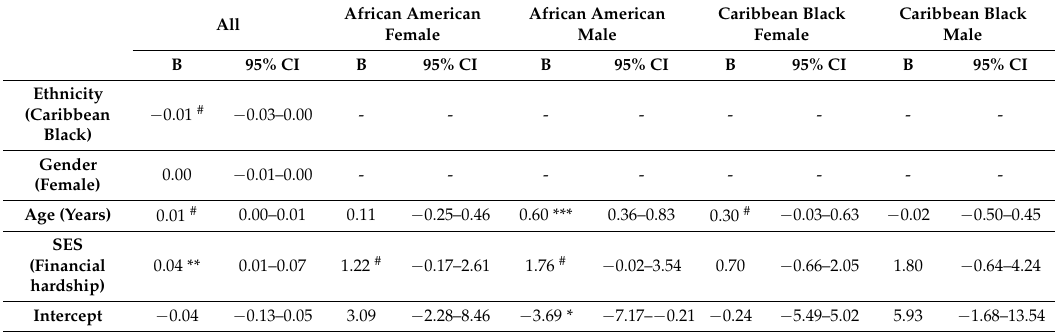
Table 4. Summary of linear regression on the effects of financial hardship on perceived